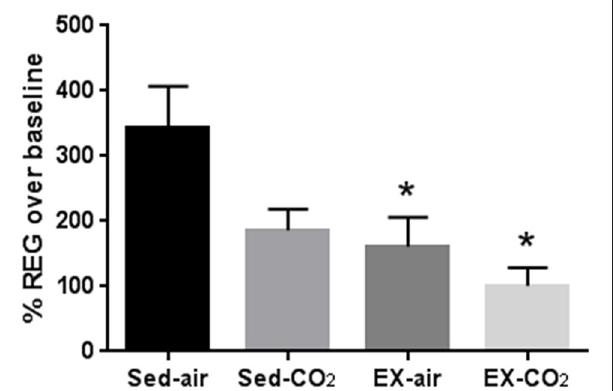
FIGURE 3 | Changes in cerebral blood flow after acute exposure to 12% CO 2 . Rheoencephalogram amplitude after acute CO 2 exposure was compared to baseline recordings on room air. *Indicates significant difference ( P < 0.05) from sedentary-air group. Sed-air ( N = 6), sed-CO 2 ( N = 8), ex-air ( N = 6), ex-CO 2 ( N =